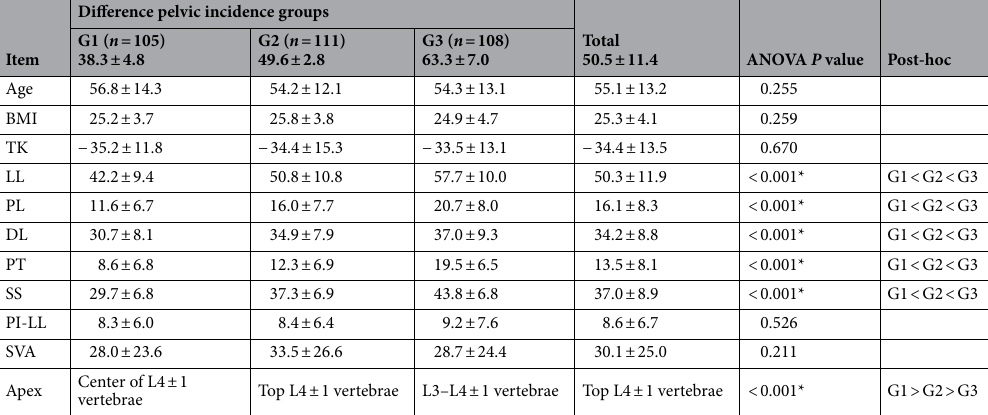
Table 1. Radiographic analysis for different pelvic incidence groups. BMI: bone mass index; DL: distal lumbar lordosis; G1: pelvic incidence < 45°; G2: pelvic incidence between 45°–55°; G3: pelvic incidence > 55°; LL: lumbar lordosis; PI-LL: the difference between pelvic incidence and lumbar lordosis; PL: proximal lumbar lordosis; PT: pelvic tilt; SS: sacral slope; SVA: C7-S1 sagittal vertical axis; TK: thoracic kyphosis. Data are presented as frequency or mean ± SD. * P < 0.05 was considered statistically